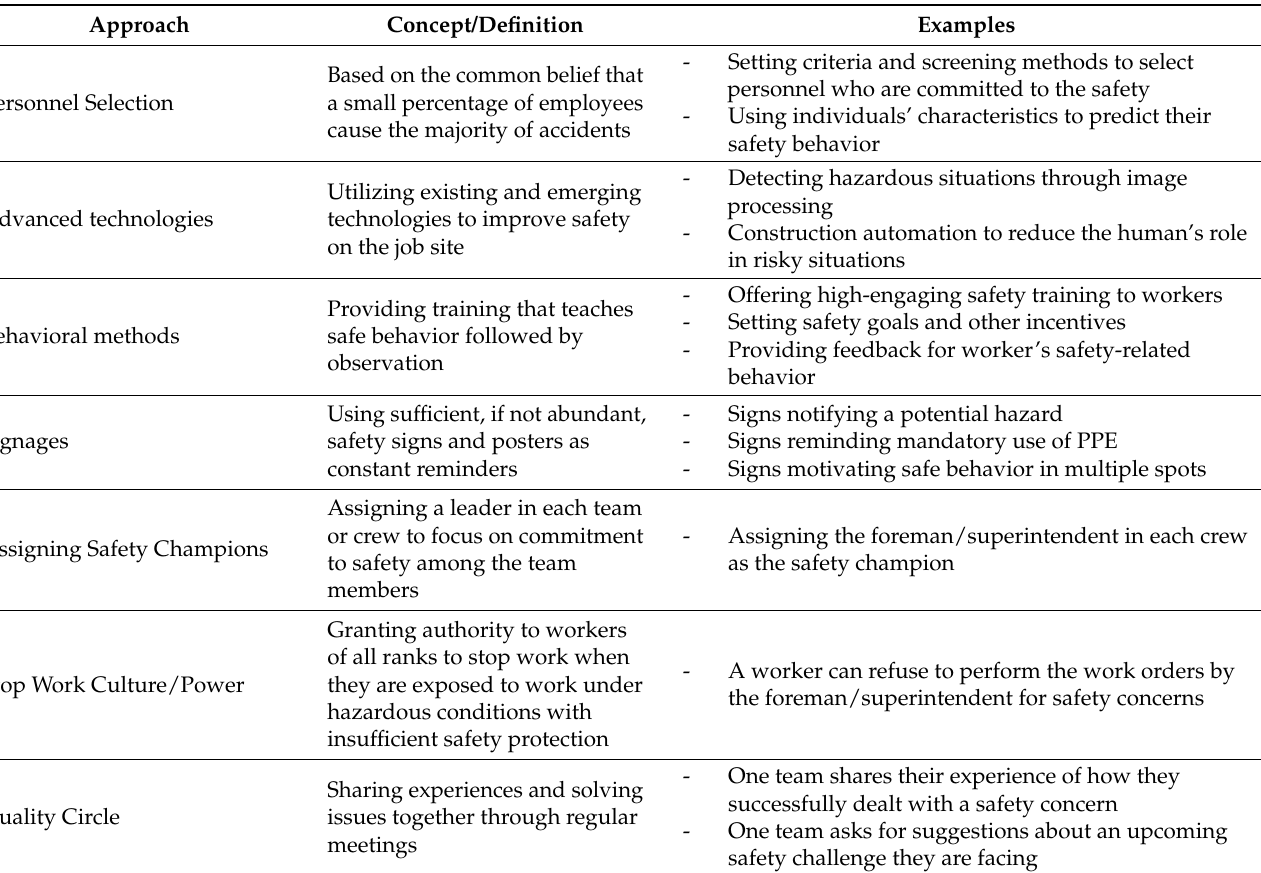
Table 2. Major safety improvement